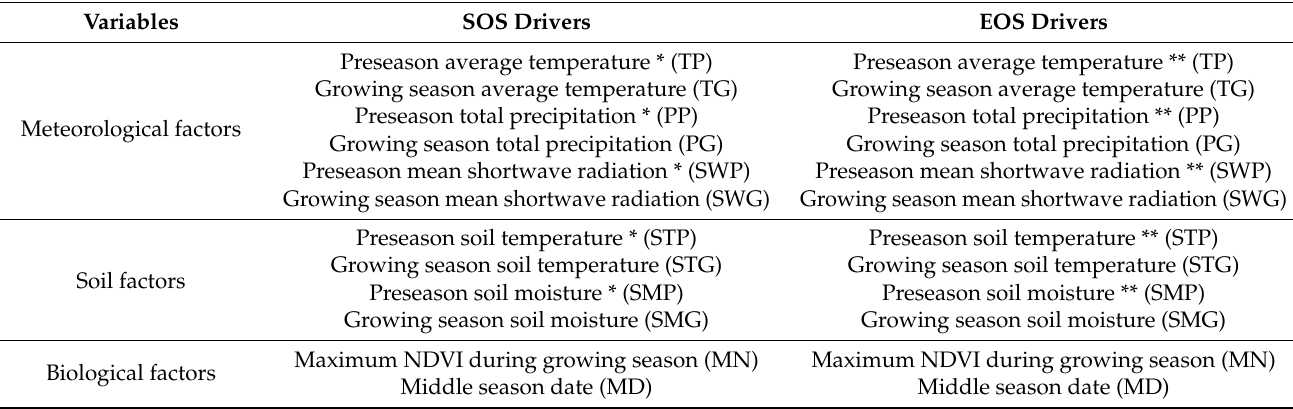
Table 3. Predictive variables used in the modeling of the LSP dates. The 12 predictive variables were classified into three categories: meteorological factors, soil factors, and biological factors. Meteorological factors include TP, TG, PP, PG, SWP, and SWG (6 in total). Soil factors include STP, STG, SMP, and SMG (4 in total). Biological factors include MN and MD (2 in total). Growing season is defined as the days between SOS and